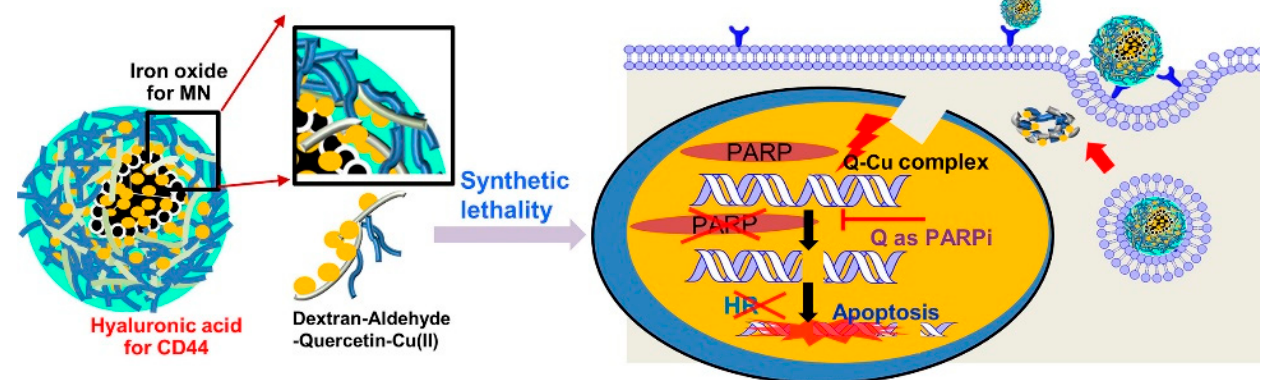
Figure 3. Graphical representation of CuQDA/IO@HA NPs for triple-negative breast cancer therapy. Reprinted with permission from ref. [115] . Copyright 2021 Elsevier, under the license number 5138830604274.